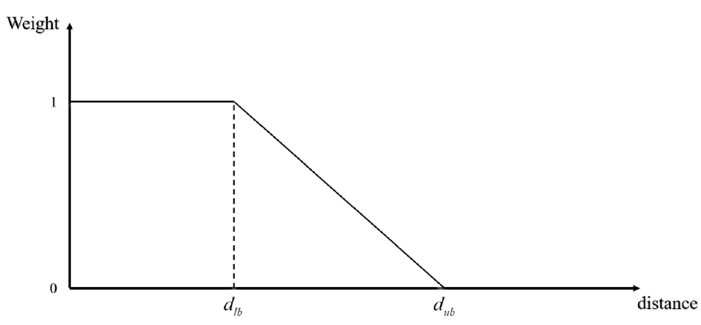
Figure 3. Illustration of a distance-decay function.